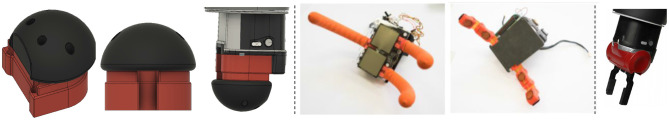
The two custom-gripper designs (left and middle) and the standard Baxter electric gripper (rightmost, Rethink Robotics, 2019).